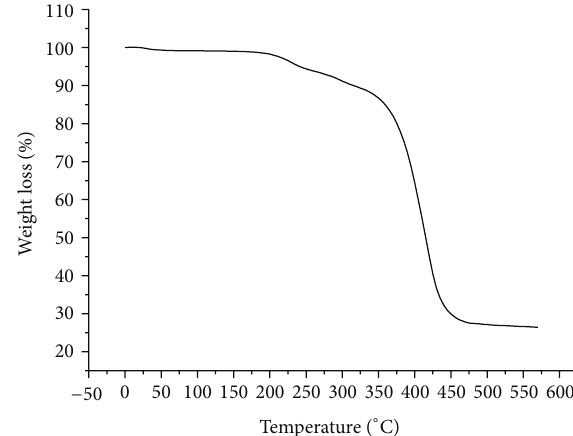
Figure 5: Thermogravimetric analysis of the cathode active mate- rial.